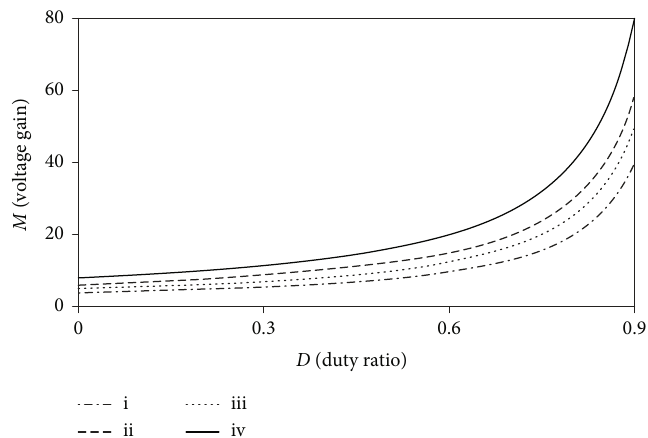
Figure 7: Comparison of the voltage gain when n = 3 . (i) Converter in [24, 27]. (ii) Converter in [29]. (iii) Converter in [30]. (iv) Proposed converter.